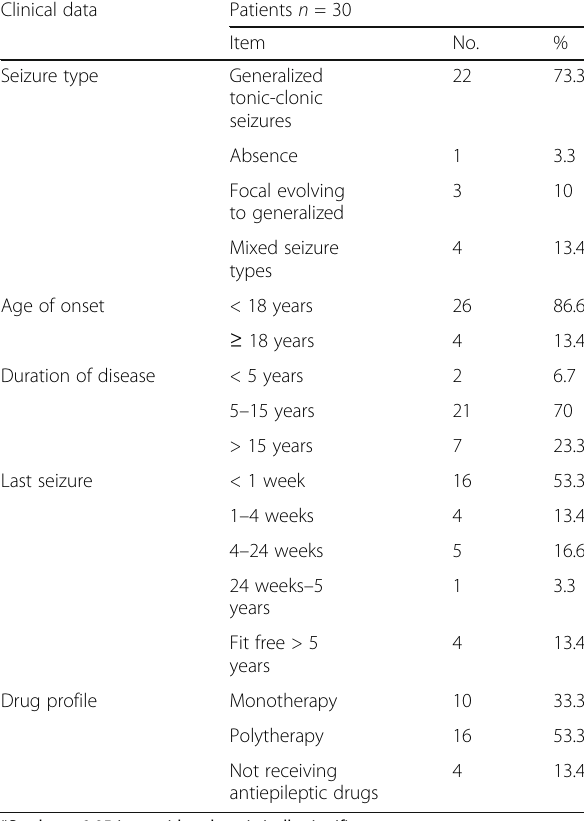
Table 1 Clinical data of the epileptic patients Clinical